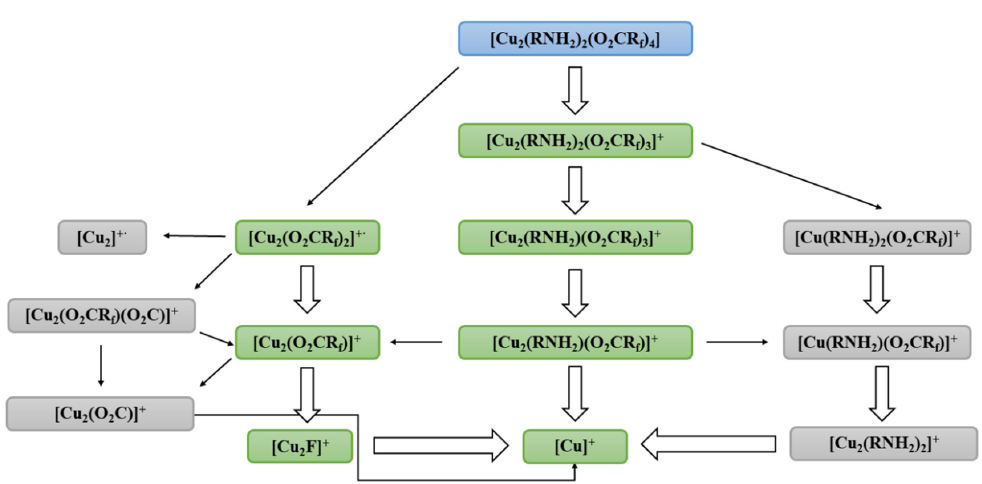
i PrNH µ -O 2 ( 2 ) 2 ( 2 CC 2 F 5 ) 4 ] ( 8 ), T = 363 K.